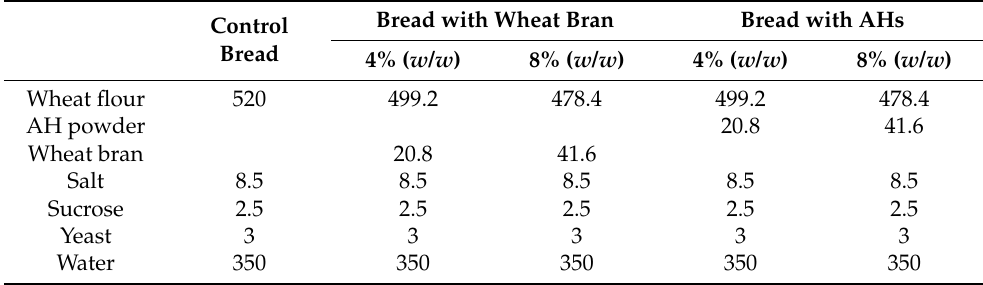
Table 1. Ingredients (g) used for the production of control and functionalised breads with AHs and wheat